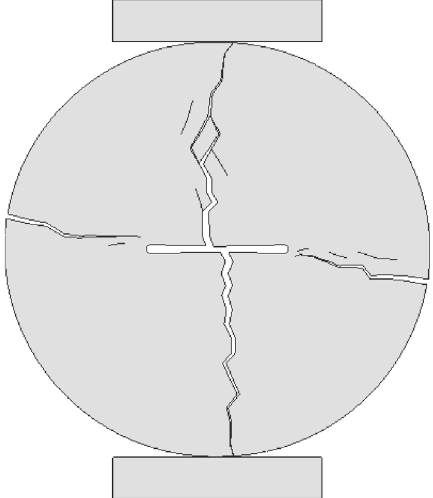
Figure 15: Failure pattern for the specimen with a preexisting crack oriented at 90 ∘ ( 2𝑎 = 15 mm) based on numerical